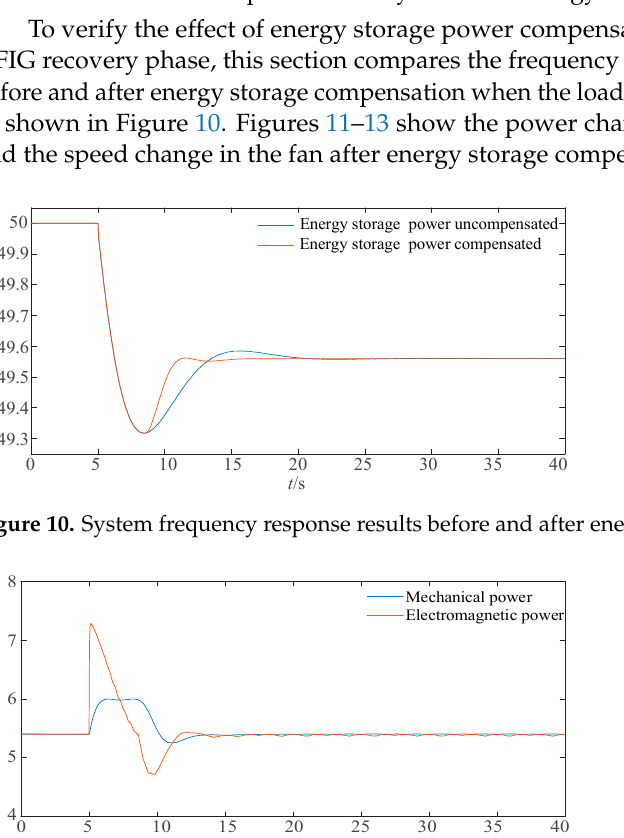
comparison when the load increases by 2.5 MW.